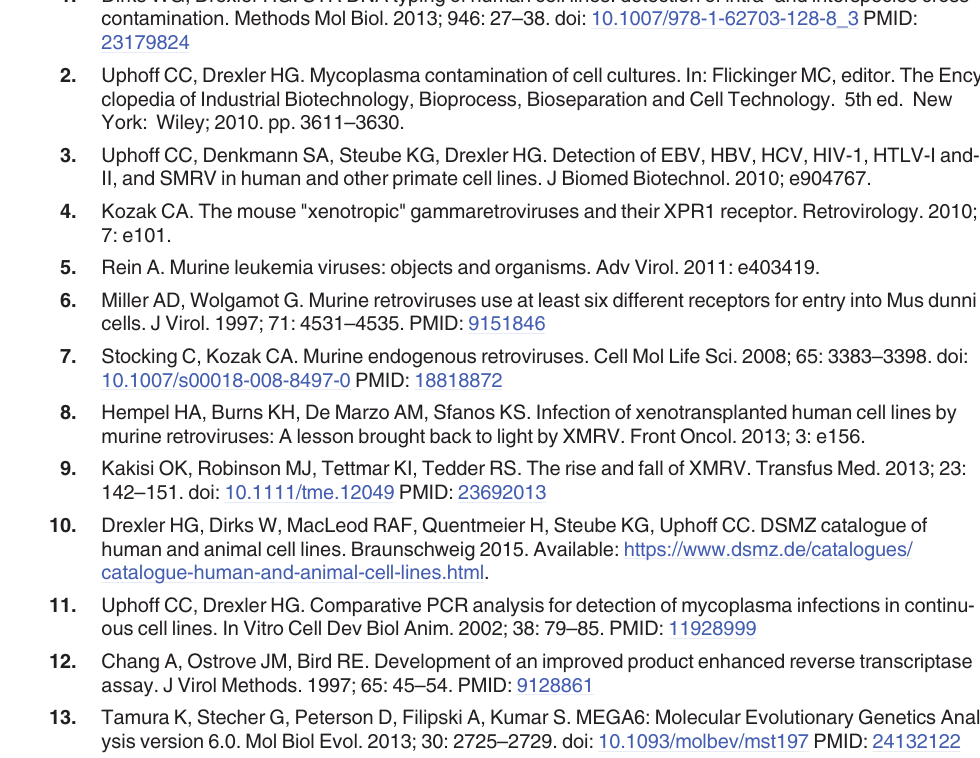
S1 Table. List of Human Cell Lines